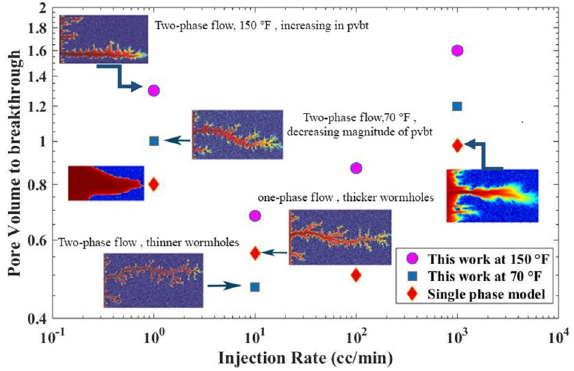
Fig. 11 Optimal patterns formed in two cases: a single phase and b two